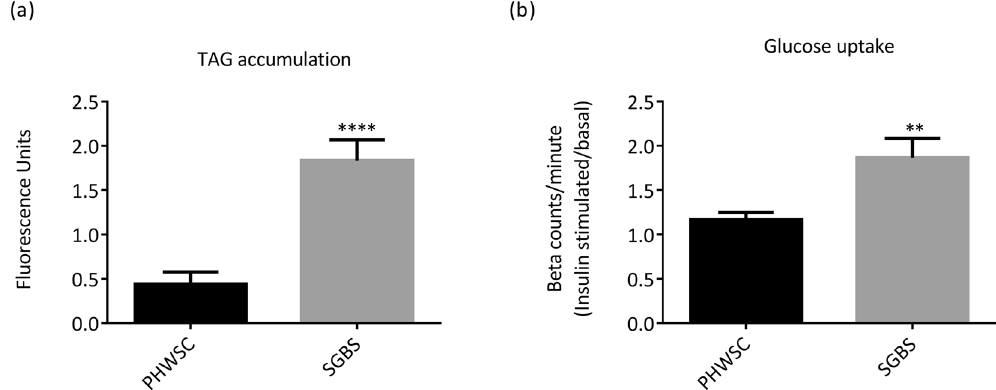
Figure 4. SGBS adipocytes have higher lipid accumulation and insulin stimulated glucose uptake. ( a ) Total lipid accumulation in SGBS and PHWSC adipocytes. Lipid accumulation was quantified as florescence after incubation of adipocytes with Nile red dye. ( b ) Relative insulin-stimulated glucose uptake assay in SGBS versus PHWSC adipocytes. Glucose uptake was measured using radiolabelled de-oxy glucose. For the experiments involving PHWSC adipocytes, experiments were performed in duplicates from cells derived from 3 different donors. For SGBS adipocytes, experiments were performed in duplicates during 3 independent experiments from the same SGBS adipocyte. Data represented as Means ± SD. ** P < 0.01, **** P <